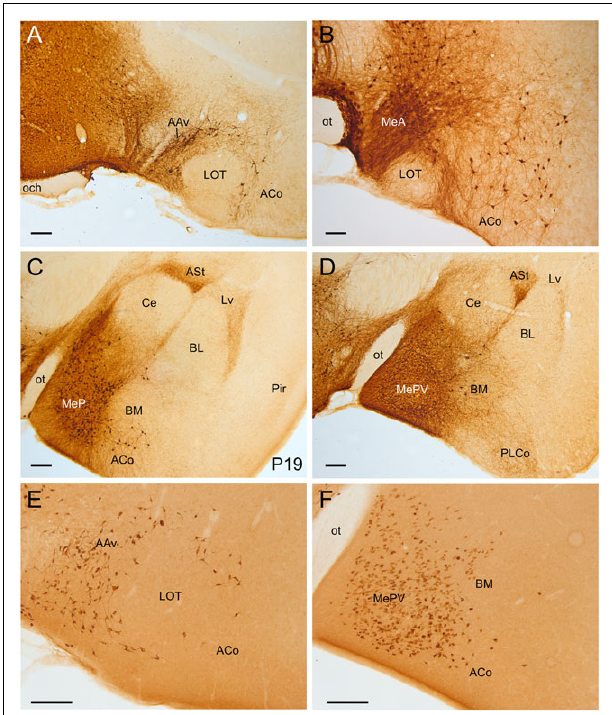
FIGURE 3 | GFP and HA immunoreactivity in the early postnatal and adult amygdala. Images of frontal brain sections of Otp-eGFP mice (A–D) and Otp-Cre; Rpl22-HA mice (E,F) , showing GFP or HA immunoreactive cells in the postnatal [ (C) , P19] and adult (A,B,D–F) amygdala. Note the highly similar distribution of cells in the medial and pallial amygdala in both transgenic mice. In the Otp-eGFP mice, the neuropil also shows immunoreactivity, allowing analysis of Otp-specific networks. See text and abbreviation list for more details. Scale bar: panels (A–F) = 200 µ